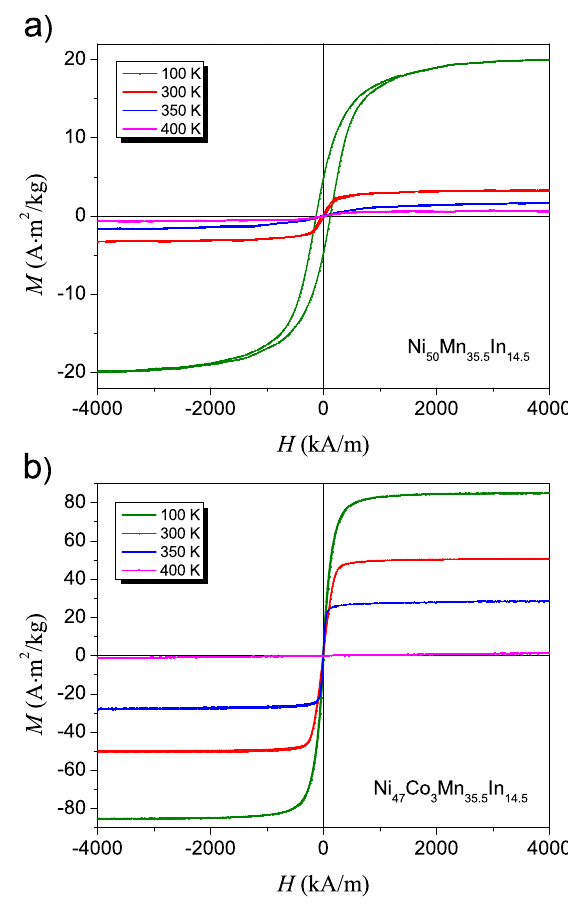
Figure 4. The field dependence of magnetization for Ni 50 Mn 35.5 In 14.5 ( a ) and Ni 47 Co 3 Mn 35.5 In 14.5 ( b ) ribbons at the selected